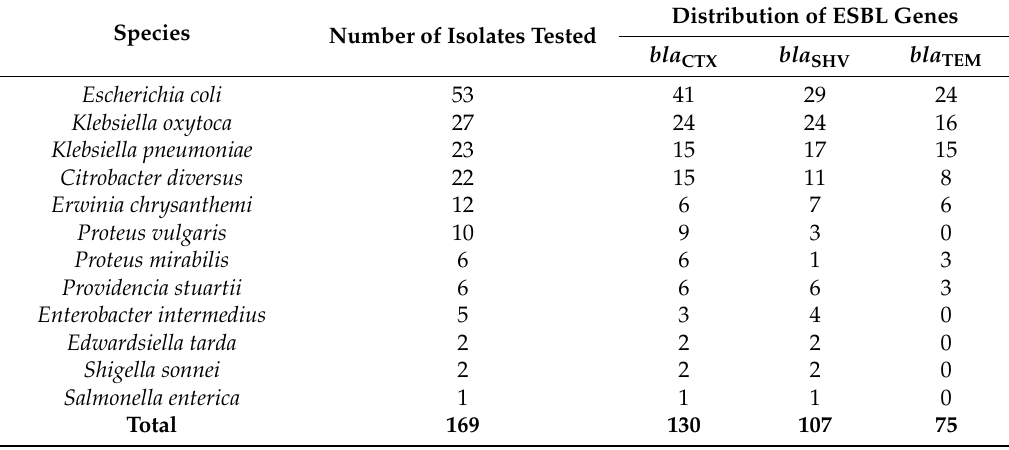
Table 4. Distribution patterns of ESBL genes in different species of enterobacteria.